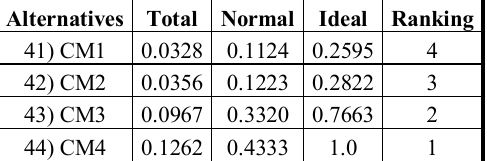
Table 6: The total weights of